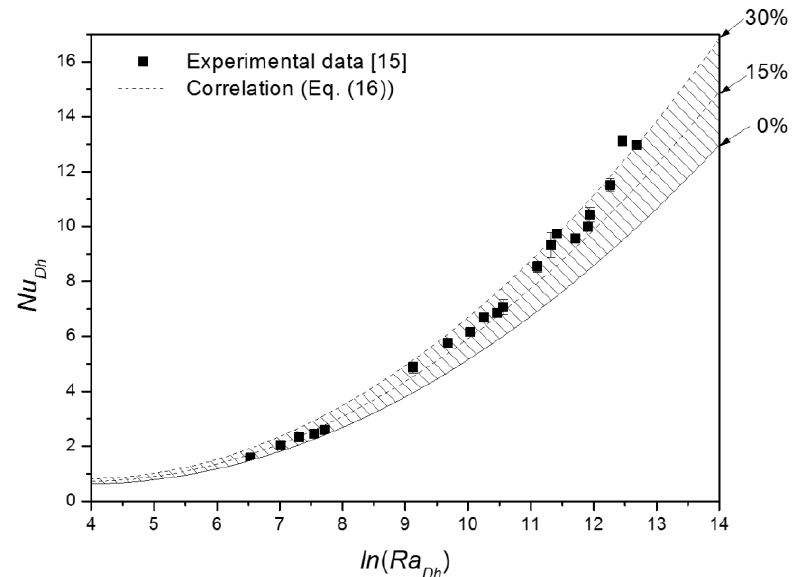
Figure B1. Nusselt numbers for radial fin heat sinks calculated using proposed correlation and those from experimental data [15].